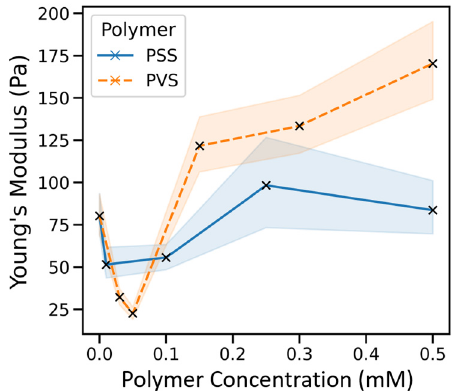
Figure 2. Impact of PSS and PVS functionalization on stiffness of 3D Coll I networks. Different functionalization concentrations of the polymers resulted in changes in Coll I network stiffness. Shown are medians with the highlighted confidence interval of 95%.